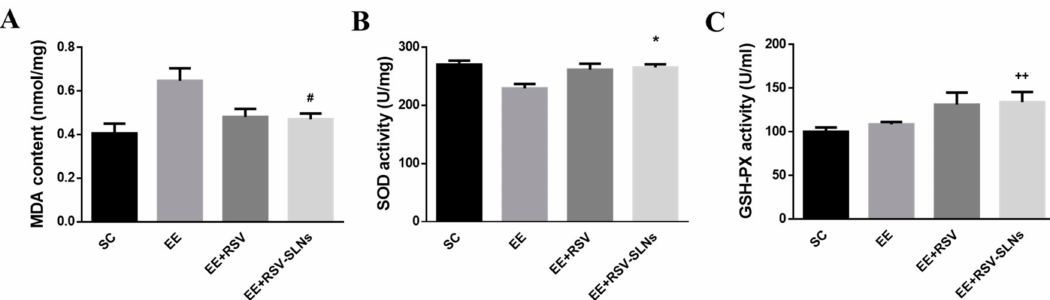
Figure 6. E ff ect of RSV-SLNs on liver biochemical variables of mice after treadmill exhausted test. The levels of MDA content ( A ), SOD activity ( B ), and GSH-PX activity ( C ) were detected in the skeletal muscle from four groups: sedentary control (SC), exhaustive exercise group (EE), exhaustive exercise combined with resveratrol supplementation (EE + RSV), exhaustive exercise combined with RSV-SLNs supplementation (EE + RSV-SLNs). # p < 0.05 compared with EE group. * p < 0.05 compared with SC group. ++ p < 0.01 compared with EE + RSV group. MDA: malondialdehyde; SOD: superoxide dismutase; GSH-PX: glutathione peroxidase.